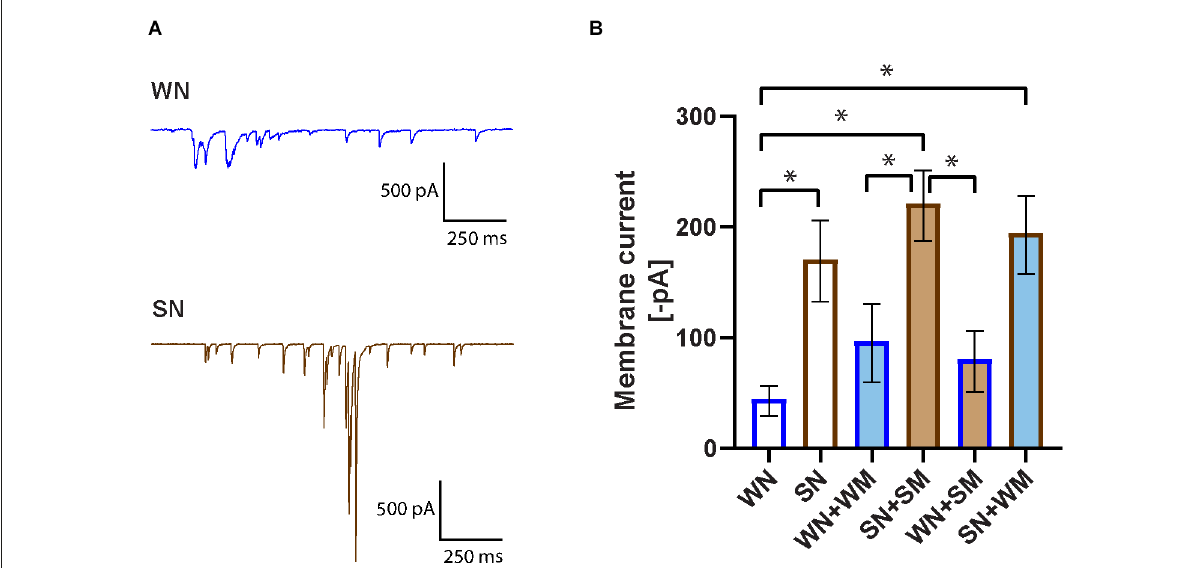
FIGURE3 Increased spontaneous activity in SHR neurons. (A) Representative voltage-clamp recordings of spontaneous activity of a WKY neuron (WN) and SHR neuron (SN) held in voltage clamp at − 60 mV. (B) Synaptic activity was quantified as membrane current (see “Methods” Section) for neurons cultured for 18–24 DIV. Bar outline denotes neuron type, fill color denotes cardiomyocyte type. Bars without fill, neurons only; dark blue line, WKY neurons; dark brown line, SHR neurons. Light blue fill, WKY cardiomyocytes; light brown fill, SHR cardiomyocytes, WN, n = 30 neurons from N = 17 primary culture preparations; SN, n = 27, N = 14; WN + WM, n = 24 N = 18; SN + SM, n = 30, N = 15; WN + SM, n = 26, N = 15; SN + WM, n = 28, N = 9; non-parametric Kruskal-Wallis test with Dunn’s multiple comparison test, ∗ p < 0.05, error bars represent s.e.m.